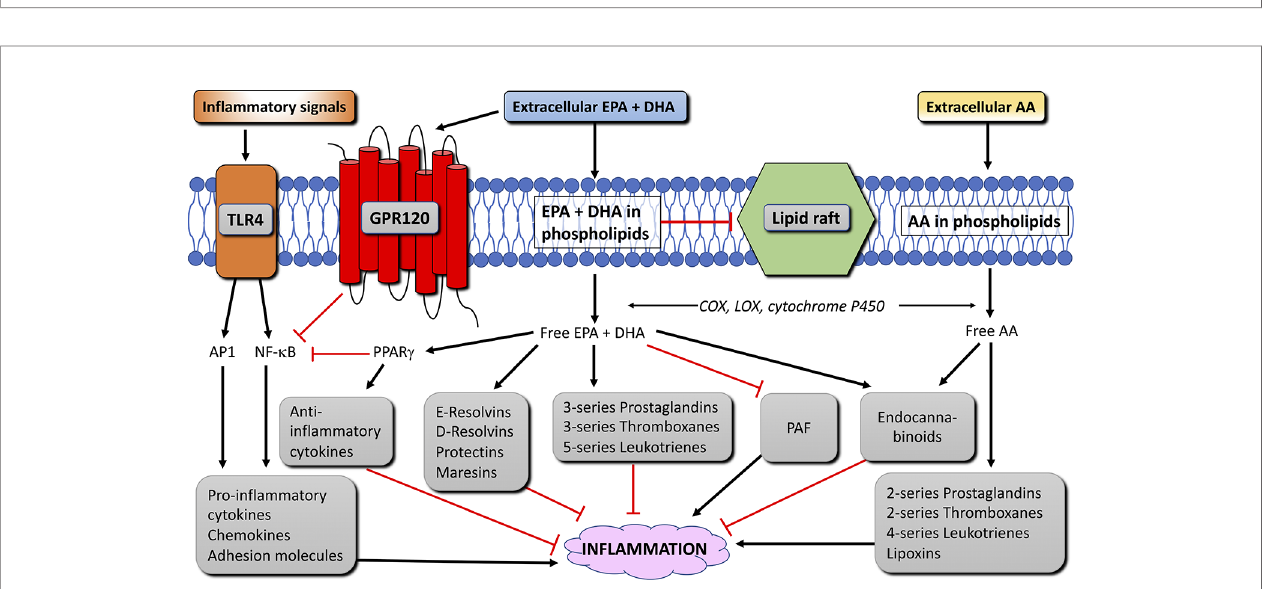
FIGURE 4 | Anti-in fl ammatory mechanisms and pathways of EPA and DHA in immune cells. Black arrow lines indicate activation, red blunted lines indicate inhibition. AA, arachidonic acid; AP1, activation protein 1; COX, cyclooxygenase; DHA, docosahexaenoic acid; EPA, eicosapentaenoic acid; GPR120, G-protein receptor 120; LOX, lipoxygenase; NF k B, nuclear factor k B; PAF, platelet-activating factor; PPAR, peroxisome proliferator activated receptor; TLR4, toll-like receptor 4 (modi fi ed from Calder,